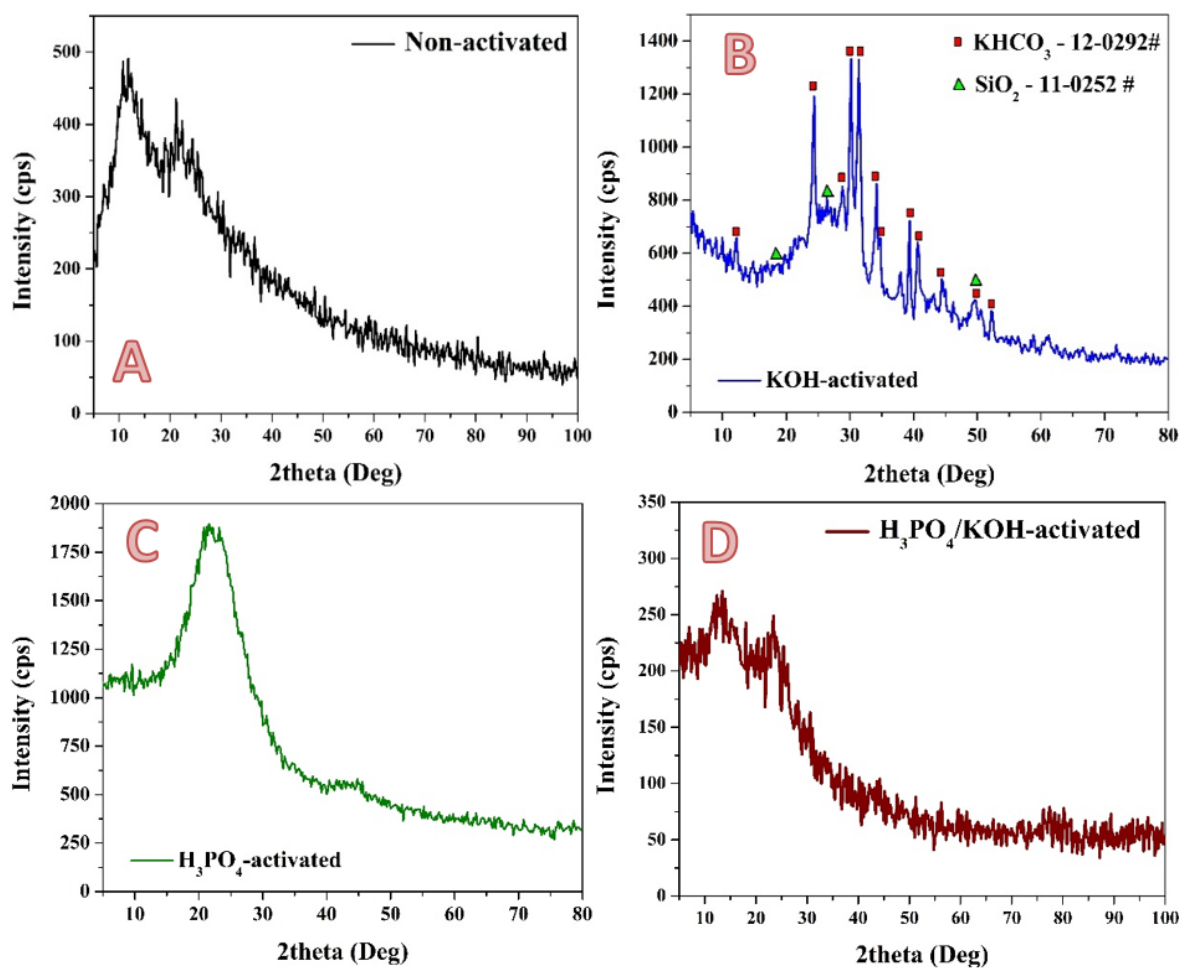
Figure 2. XRD patterns of non-activated; ( A ), and activated by KOH only; ( B ), H 3 PO 4 only; ( C ) and combined H 3 PO 4 –KOH solution; ( D ) rice husk carbonized powder. The used solution was 14